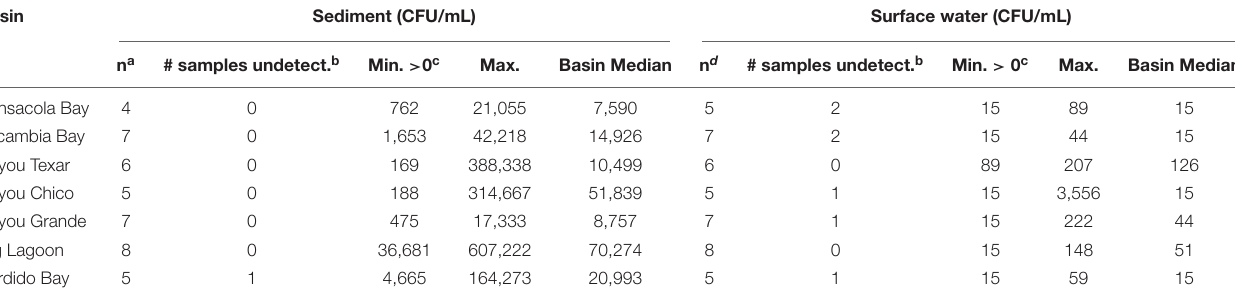
TABLE 3 | Abundances of culturable Vp in sediments and surface waters. Medians and ranges in each basin are provided. Basin